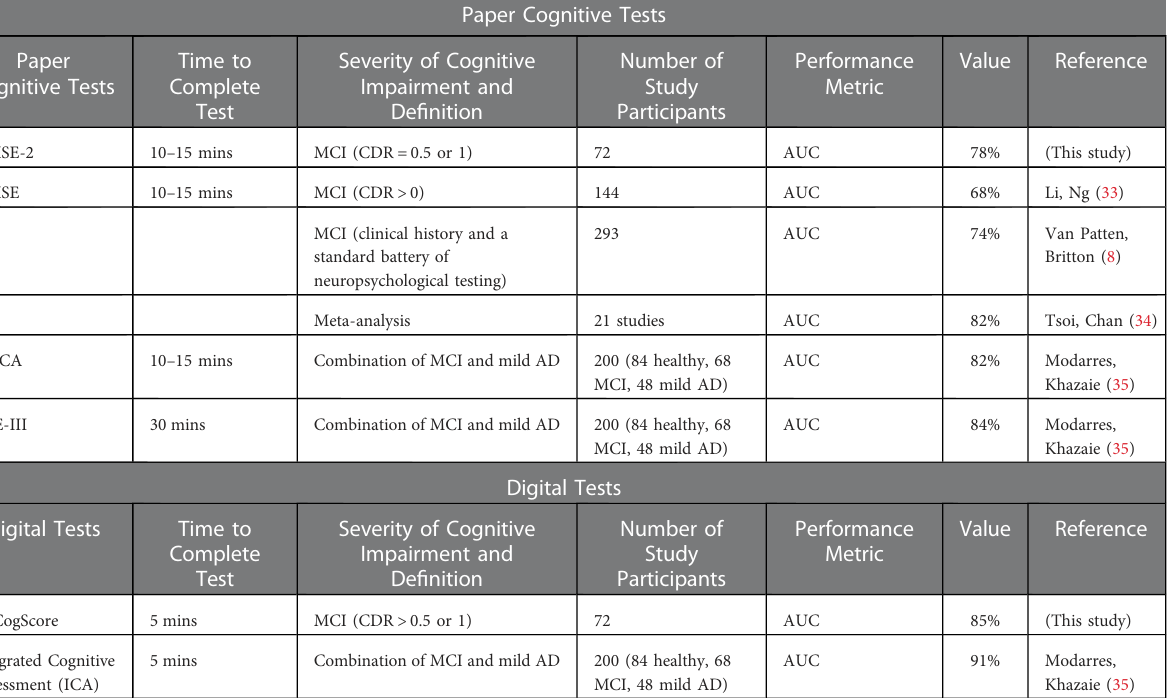
Paper Cognitive